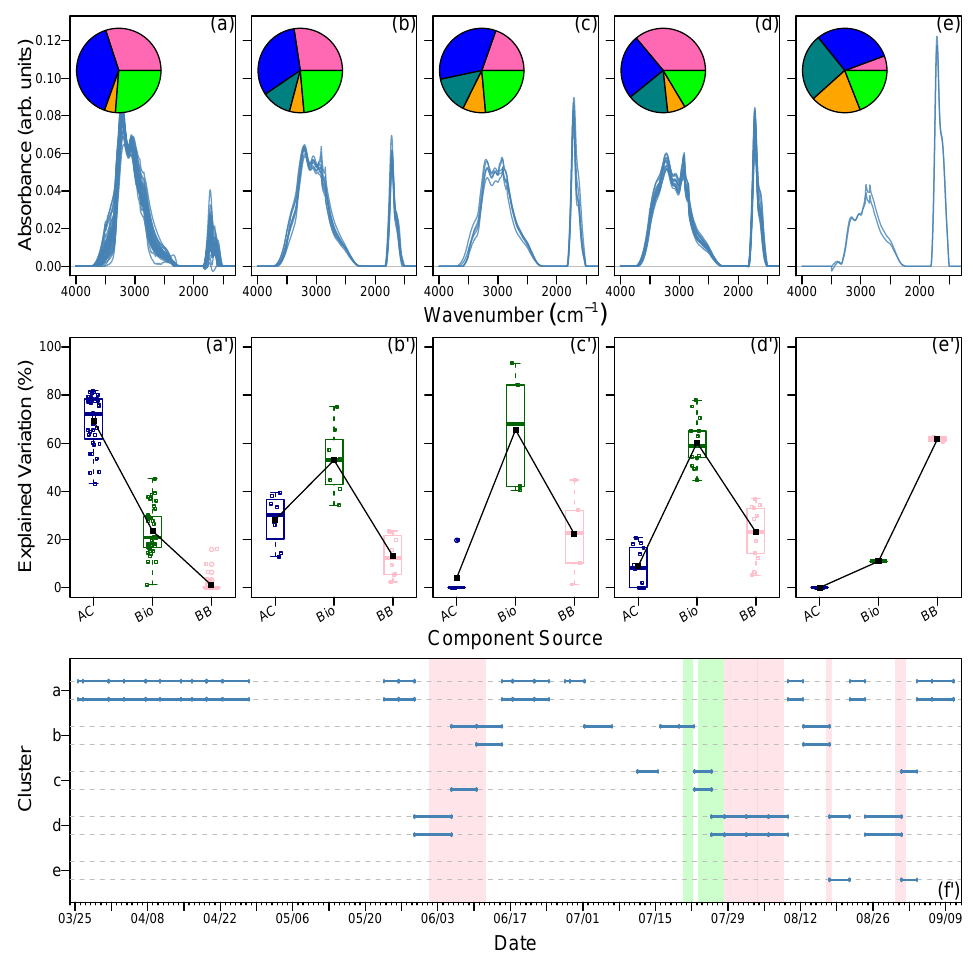
Fig. 9. (a) – (e) Clustered FTIR spectra of submicron aerosol with inset pie graphs depicting average relative contributions of each functional group to OM: hydroxyl (pink), alkane (blue), acid (green), ketones (teal), and primary amine (orange) groups. (a’) – (e’) Relative contributions (as Explained Variance) from regression analysis for anthropogenic combustion (AC), biogenic (Bio), and biomass burning (BB) components shown as box-and-whisker plots, with individual points overlaid for each category. (f’) Time series indicating membership of samples to one of five clusters (labeled on y-axis) introduced in top row. Bars horizontally span sampling periods for each filter; positive and negative vertical offsets indicate day or night samples respectively. Pink indicates periods with biomass burning influence, and green indicates periods with primarily non-burning biogenic